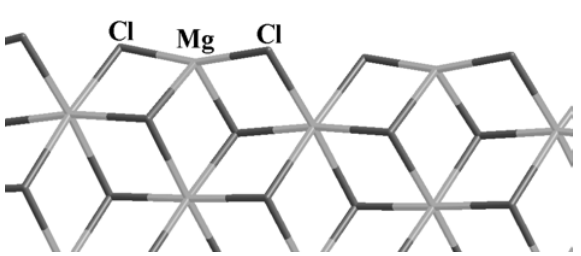
surface. The Mg atoms are located at the cross points of the light Figure 1. The relaxed (110) MgCl 2 gray sticks, while Cl atoms are represented by the darker segments as indicated by the labels.